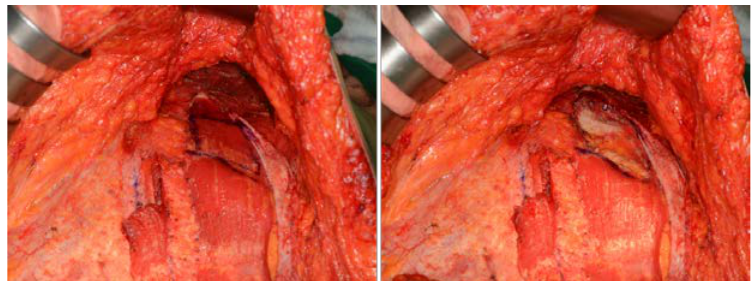
Figure 5. ( Left ) A rectus abdominis muscle inserted into the costal cartilage of the fifth, sixth, and seventh ribs was marked. ( Right ) Image taken after muscle removal. Muscle resection must be limited to just above and lateral to the costal margin to ensure muscle preservation.